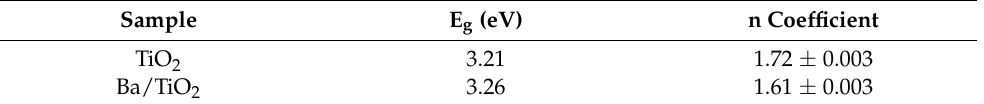
Table 2. n coefficient determination and band gap.